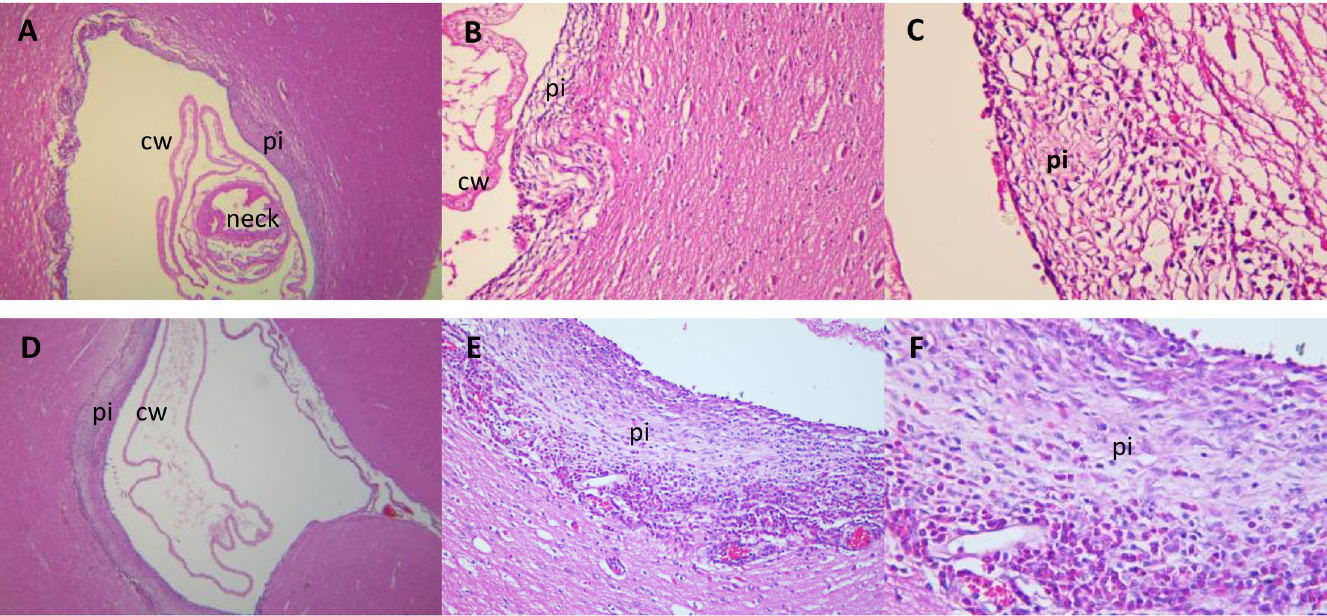
Fig 3. Histopathology of H&E-stained sections of two brain cysticerci with pericystic inflammation recovered from different experimental NCC pigs. (A), (B), and (C) show a parenchymal cyst with adjacent tissue at x4, x20, and x40 magnification respectively. Moderate pericystic inflammation in all areas surrounding the parasite is observed with a moderate number of inflammatory cells (mainly eosinophils and lymphocytes), and cyst wall and neck appears to be intact. (D), (E), and (F) show a corticomeningeal cyst with abundant pericystic inflammation in the cortical parenchyma at x4, x20, and x40 magnification. Three pericystic cell layers were observed, the first corresponded to abundant epithelioid cells, eosinophils, and macrophages dispersed between collagen fibers. The second layer includes numerous eosinophils and macrophages. The third layer included plethoric meningeal vessels with abundant extravasated eosinophils, lymphocytes, and epithelioid cells. Cyst wall appeared with slight damage. Key: cw = cyst wall; pi = pericystic inflammation.